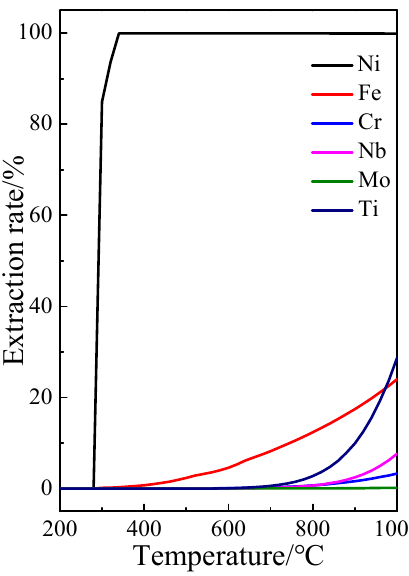
Figure 4. Simulation of the extraction process at different temperatures using Factsage [32]. (In the calculation process, it was assumed that the masses of the initial superalloy and Mg-Zn alloy were 100 g and 500 g, respectively. The Mg-Zn alloy contains 267.8 g of Zn and 232.2 g of Mg; liquid 1# in the Factsage calculation results were adopted.).